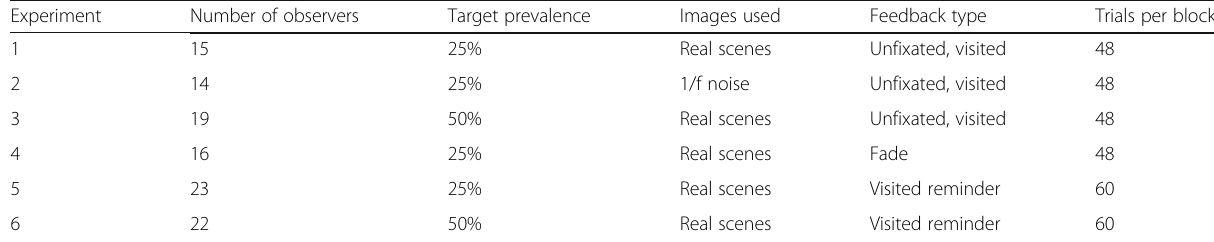
Table 1 Experiment overview Experiment